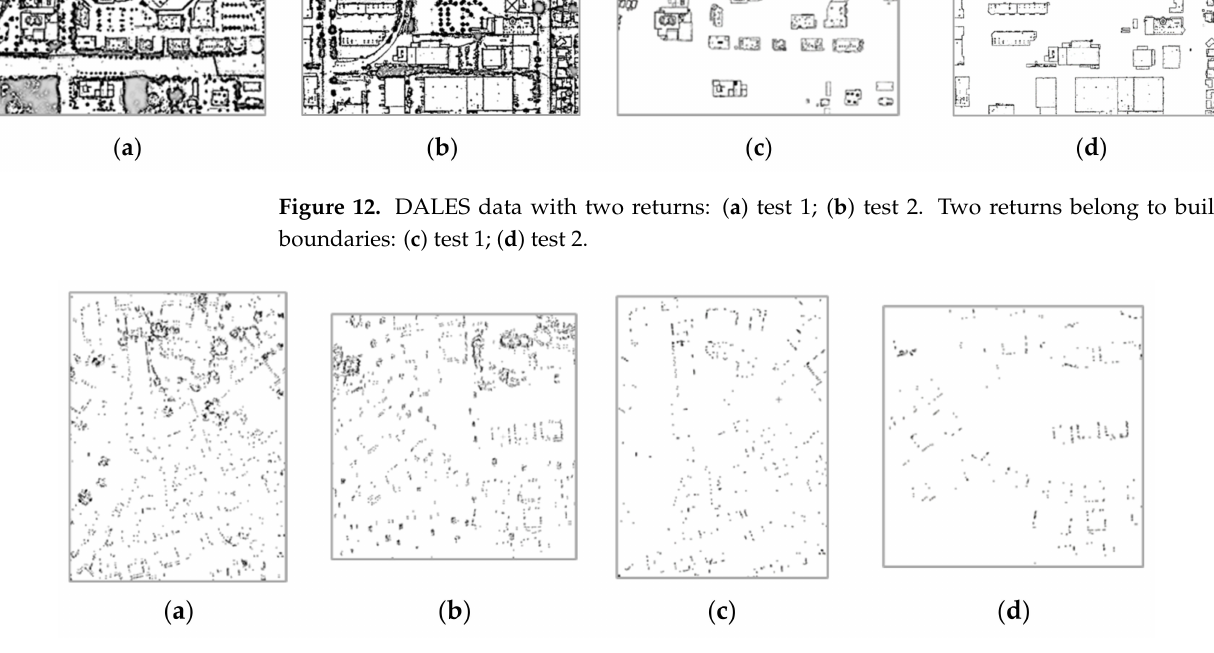
Figure 13. ISPRS Vaihingen data with two returns: ( a ) new 1; ( b ) new 2. Two returns belong to building boundaries: ( c ) new 1; ( d ) new